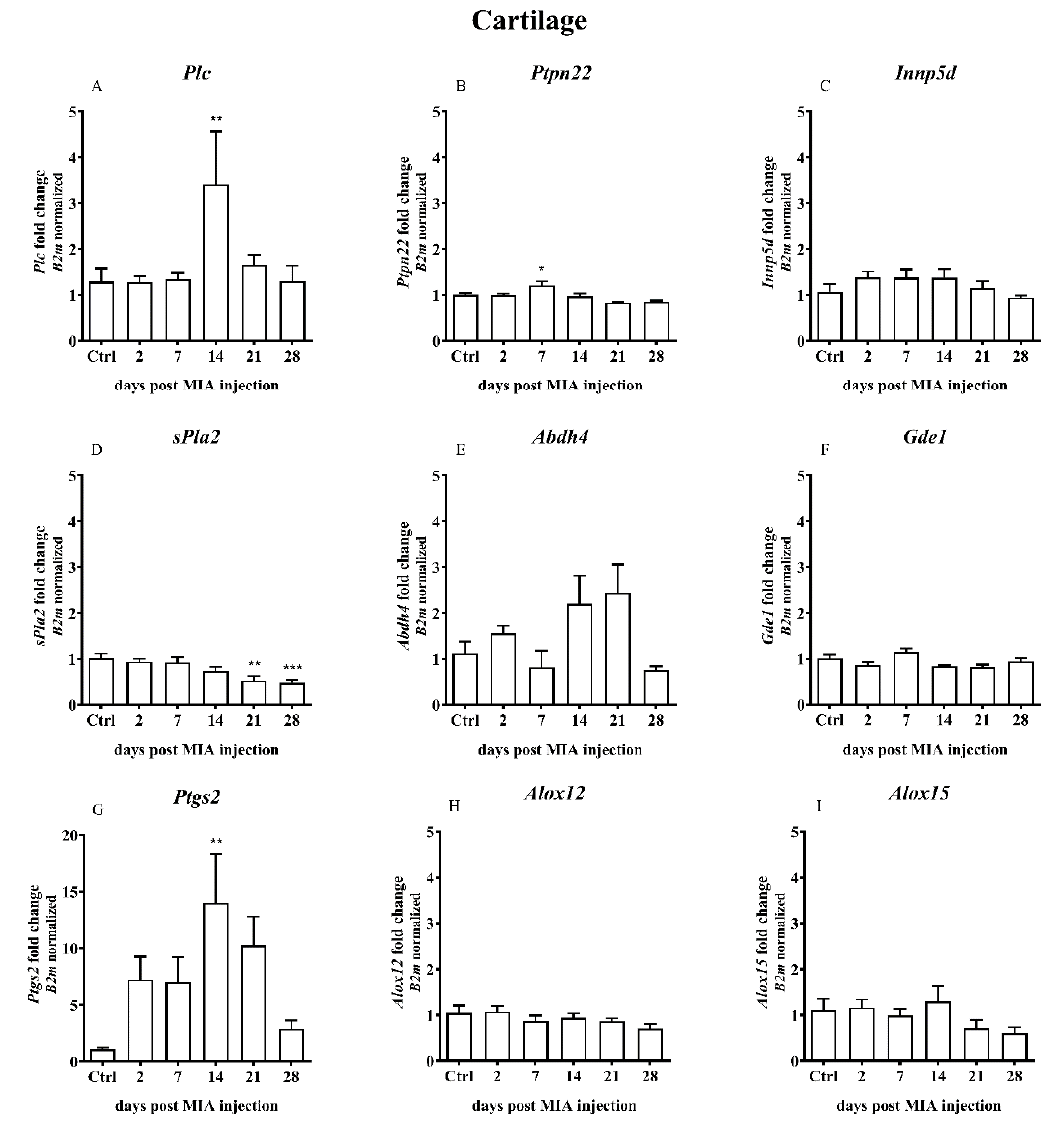
Figure 6. Transcript levels of the alternative AEA synthesis and degradation pathways ( A – I ), including phospholipase C ( Plc ), protein tyrosine phosphatase, non-receptor type 22 ( Ptpn22 ), inositol polyphosphate-5-phosphatase D ( Inpp5d ), phospholipase A2 ( sPla2g2a ), β hydrolase domain containing protein 4 ( Abdh4 ), glycerophosphodiester phosphodiesterase 1 ( Gde1 ), prostaglandin-endoperoxide synthase 2 ( Ptgs2 ), arachidonate 12-lipoxygenase ( Alox12 ) and arachidonate 15-lipoxygenase ( Alox15 ), in the cartilage of rats after 3 mg MIA injection during OA development. The samples were collected 2, 7, 14, 21 and 28 days after MIA injection; the control group did not receive any treatment. The groups contained 3–6 samples. Data are presented as the mean ± SEM of fold changes of the group average normalized versus the reference gene ( B2m ). Statistical analysis was performed using one-way ANOVA followed by Dunnett post hoc-test (intact animals treated as a control group). * denotes p < 0.05; ** denotes p < 0.01; *** denotes p < 0.001 vs. intact animals.